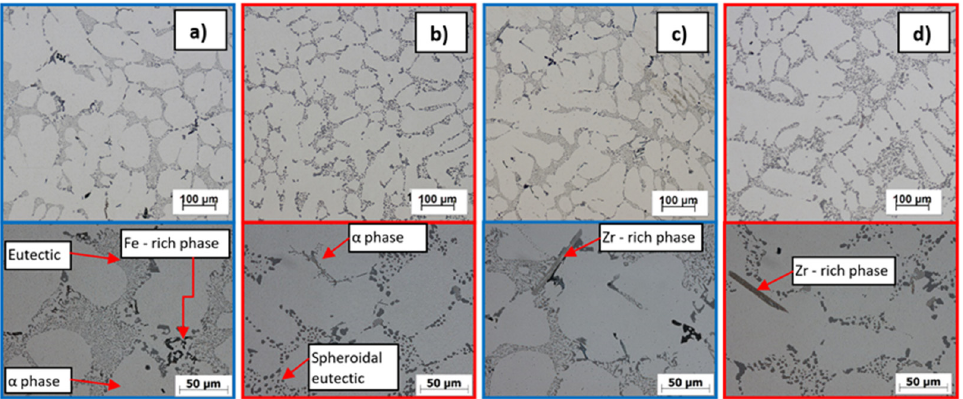
Figure 4. Microstructure of experimental alloys, H 2 SO 4 etch.; ( a ) R—AlSi7Mg0.3Cu0.5 alloy in cast state, ( b ) R—AlSi7Mg0.3Cu0.5 alloy after heat treatment, ( c ) P—AlSi7Mg0.3Cu0.5Zr0.15 alloy in cast state, and ( d ) P—alloy AlSi7Mg0.3Cu0.5Zr0.15 after heat treatment.